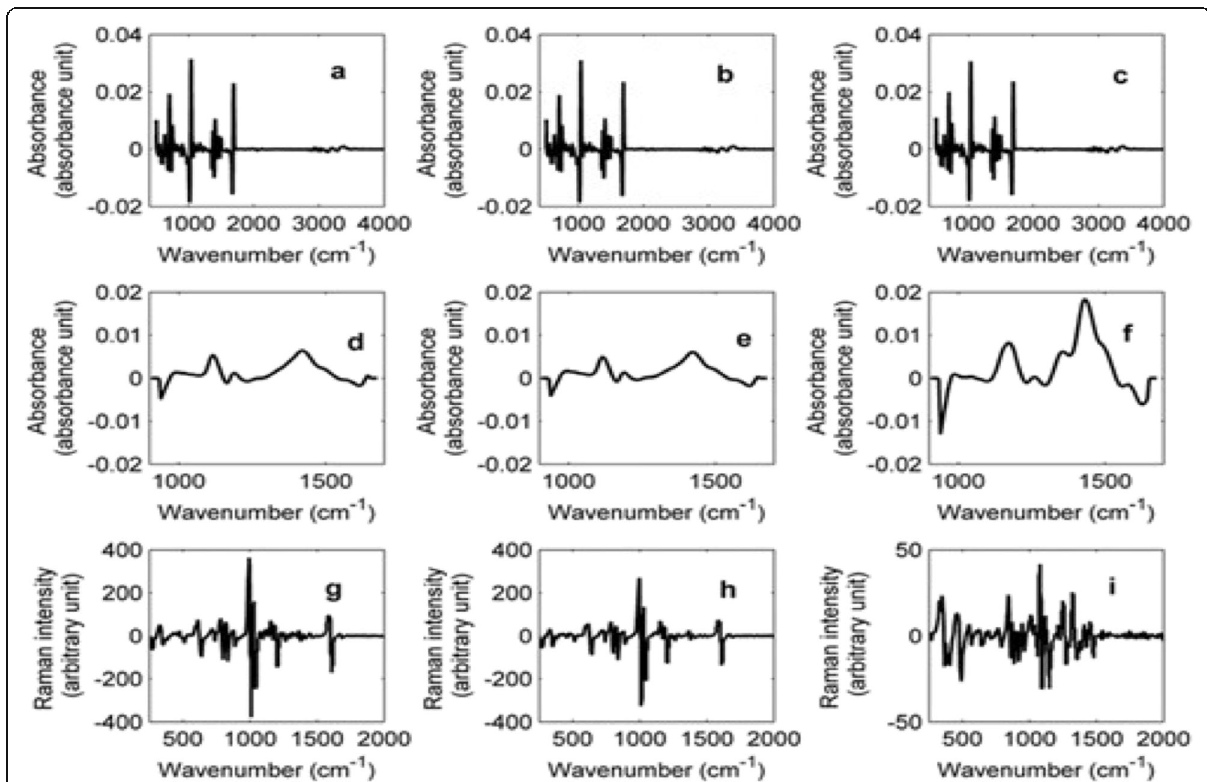
Fig. 1 MSCD1 treated ( a ) FTIR spectrum modafinil tablets. b FTIR spectrum of pure modafinil. c FTIR spectrum lactose monohydrate. d NIR spectrum modafinil tablets. e NIR spectrum of pure modafinil. f NIR spectrum lactose monohydrate. g Raman spectrum modafinil tablets. h Raman spectrum of pure modafinil. i Raman spectrum lactose monohydrate measured using the Bruker Alpha FTIR, JDSU microNIR and Rigaku handheld Raman instruments,